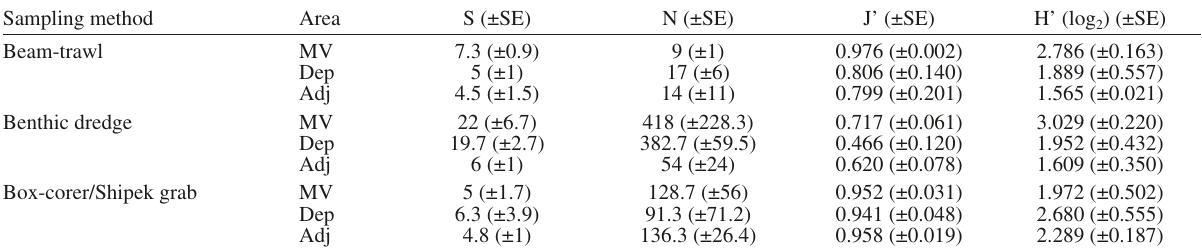
Table 4. – Mean values of ecological indexes of species collected alive in the areas of the Gazul mud volcano (MV, mud volcano edifice; Dep., erosive depression; Adj., adjacent bottoms) for each sampling method. SE, standard error; S, species richness; N, abundance; J’, evenness index; H’ (log ), Shannon-Wiener diversity 2